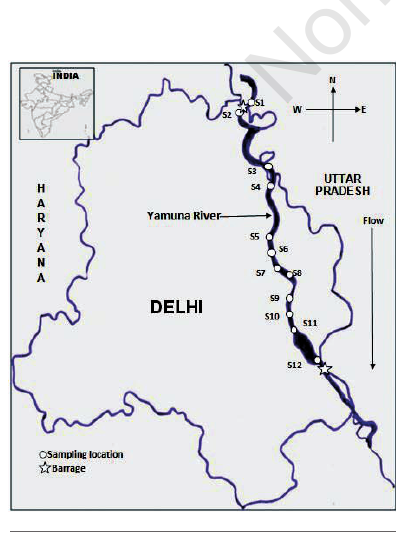
Figure 1. Map showing sampling locations on the Yamuna River in Delhi, India.